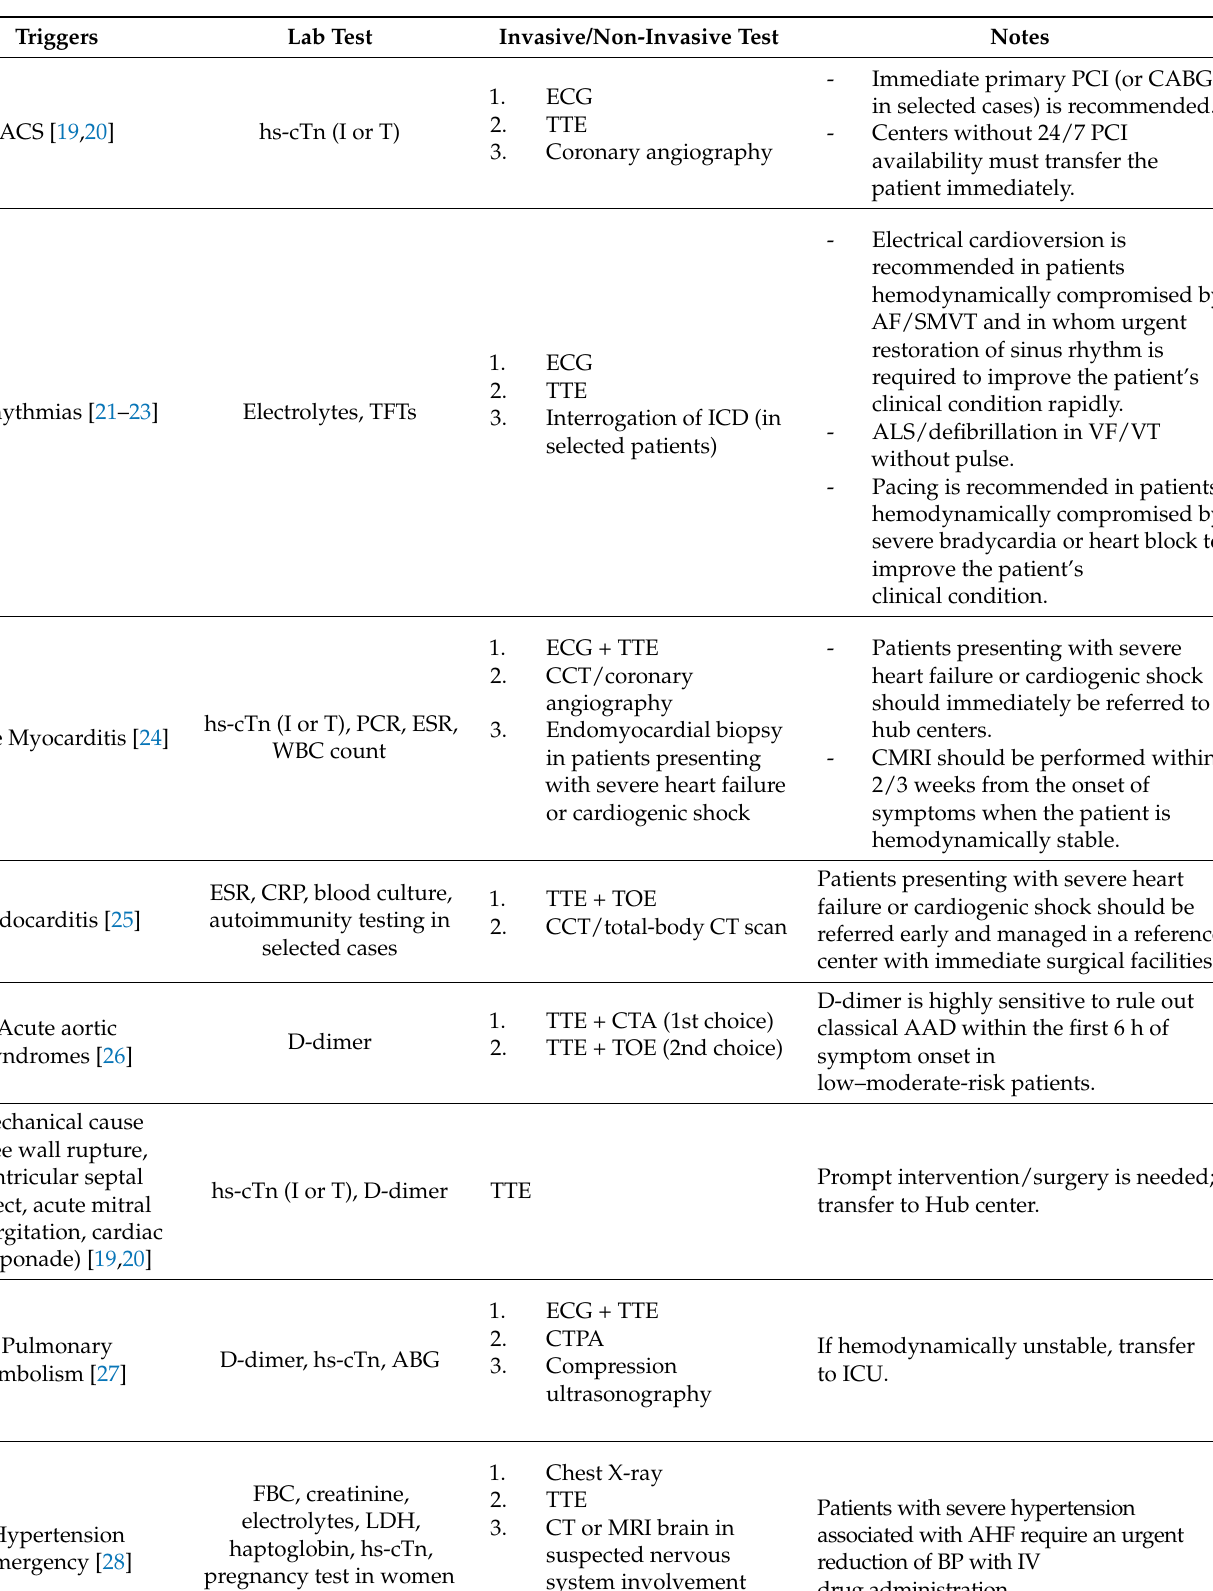
Table 2. Triggers of